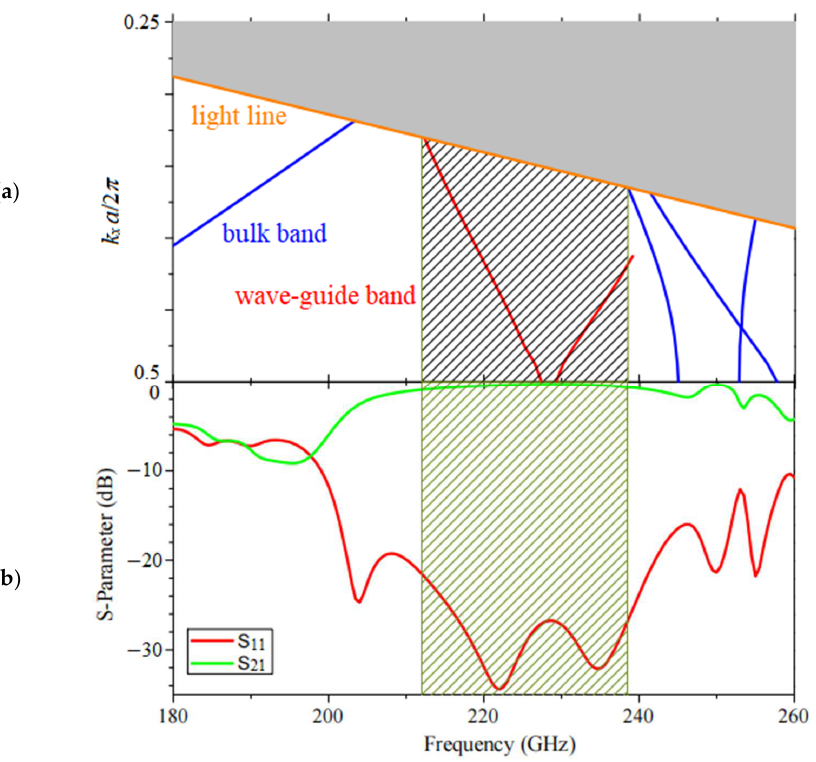
Figure 2. Projected band structure of PC wave-guide ( a ) and the propagation characteristics ( b ). The frequency range under PBG is covered with the section line.